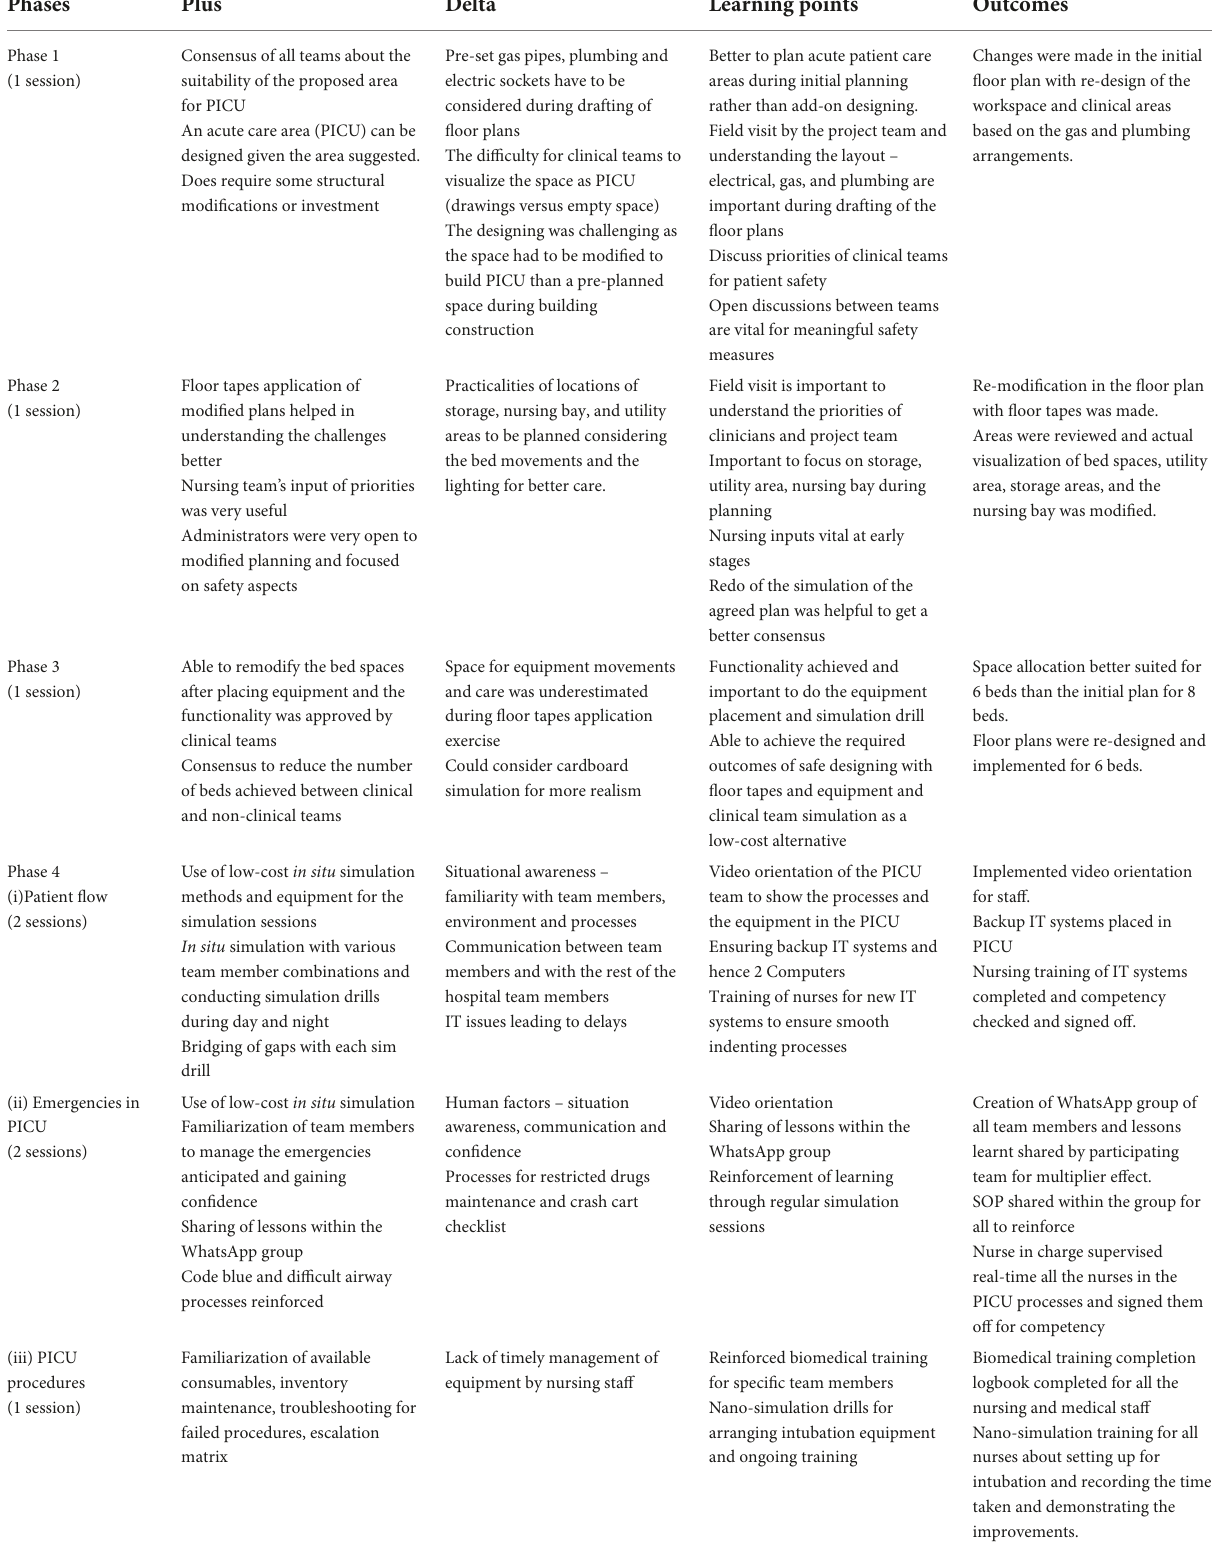
TABLE 2 Key debriefing points during each phase of simulation and outcomes. Phases Plus Delta Learning points